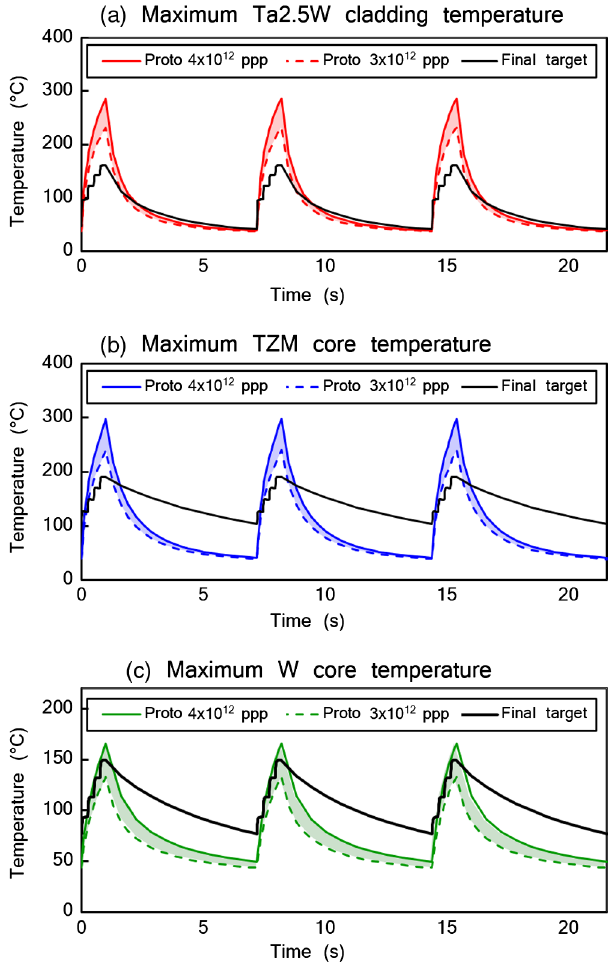
FIG. 6. Temperature evolution expected in the target materials during three beam pulses under steady-state regime, which is reached after around six pulses on target ( < 1 min operation). The temperature values are taken in the location of maximum temperature for the different target materials. Comparison be- tween the final target and the target prototype operation under 3 × 10 12 and 4 × 10 12 protons per